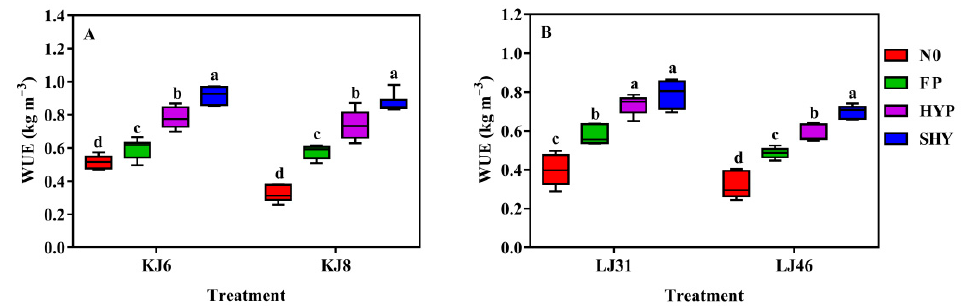
Figure 3. Water-use efficiency (WUE) of different varieties, in different sites (( A ) in Daqing; ( B ) in Suiling) and under different cultivation patterns (N0, FP, HYP, and SHY). KJ: Kenjing 6; KJ8: Kenjing 8; LJ31: Longjing 31; LJ46: Longjing 46; N0: no nitrogen application; FP: local farmer practice; HYP: high-yield, high-efficiency practice; SHY: super-high-yield practice. Bars are mean ± SE ( n = 3). Different letters indicate statistical significance at the p < 0.05 level under different treatments.